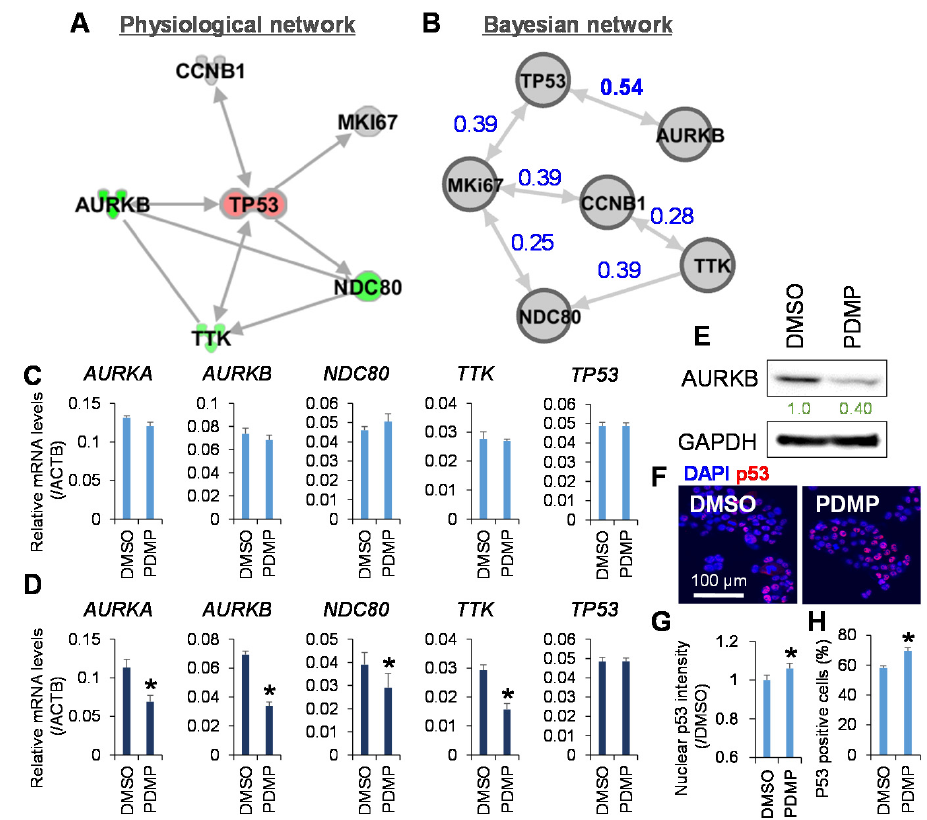
Figure 5. Inhibition of ganglioside synthesis targets kinetochore metaphase signaling in liver cancer cells. ( A ) Physiological network generated using the Ingenuity Knowledge Base of the IPA software. ( B ) Bayesian network generated using the score-based hill-climbing learning algorithm in the bnlearn R package and visualized using Gephi software. Expression of genes involved in kinetochore metaphase signaling pathway in the HCC cell line, JHH7, treated with vehicle control DMSO or ganglioside synthesis inhibitor PDMP at 25 µ M for 4 h ( C ) and 24 h ( D ) using real-time PCR. ( E ) Western blot analysis of AURKB and GAPDH in JHH7 cells treated with vehicle control DMSO or 25 µ M PDMP for 24 h. Band intensities were quantified using Image J software. The protein level of AURKB was normalized to GAPDH and expressed as fold change compared with vehicle control DMSO set as 1. ( F ) Immunofluorescence staining for p53 in JHH7 cells treated with vehicle control DMSO or 25 µ M PDMP for 24 h. Scale bar, 100 µ m. ( G ) The relative fluorescent intensity of nuclear p53 protein vs. vehicle control DMSO. ( H ) Percentages of p53 positive cells among the total number of JHH7 cells counted. The data are presented as means ± SD. * p < 0.05 in Student’s t